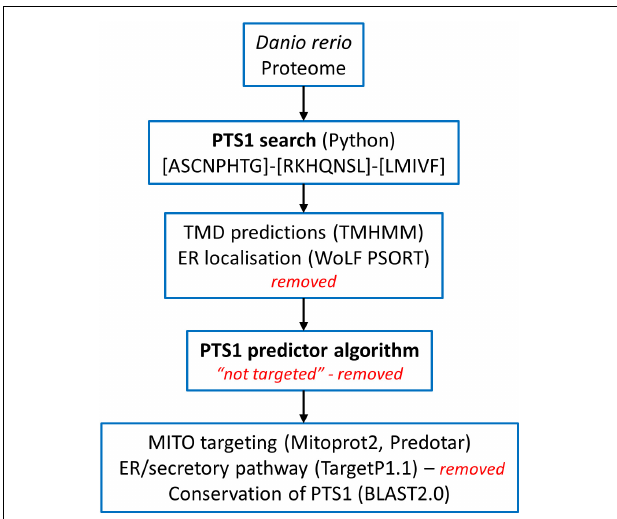
FIGURE 1 | Overview of the screening of the Danio rerio proteome to identify candidate proteins with a C-terminal peroxisomal targeting sequence (PTS1). See Materials and Methods for